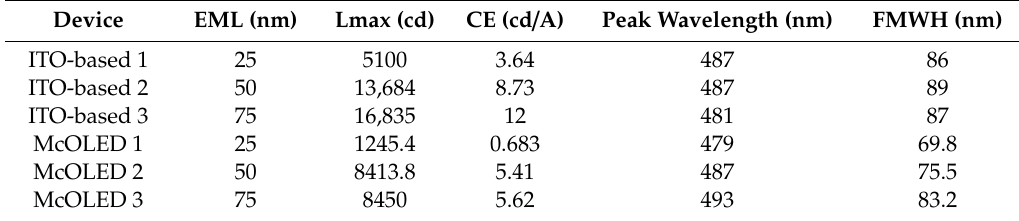
Table 1. The electroluminescence device performances of ITO-based OLEDs and micro-cavity OLEDs.